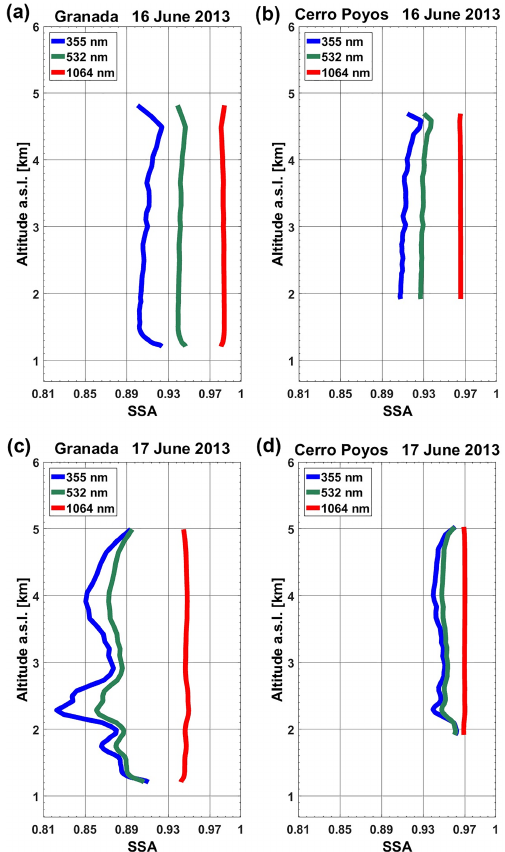
Figure 9. Single-scattering albedo profiles at 355, 532 and 1064nm retrieved by GRASP on 16 (a, b) and 17 (c, d) June 2013 at Granada (a, c) and Cerro Poyos (b, d) .